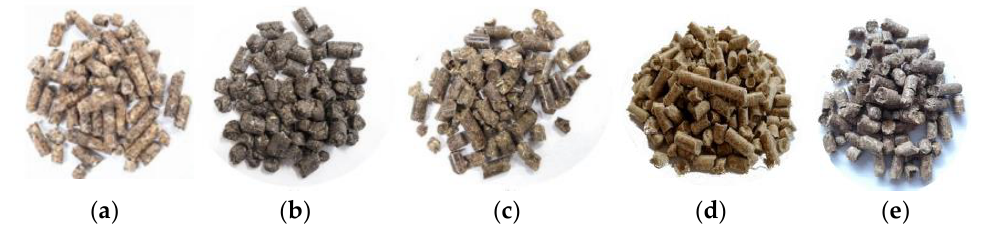
Figure 1. Pellets investigated in the study: sunflower husk ( a ), beetroot pomace ( b ), grass ( c ), pine tree ( d ), and wheat straw ( e